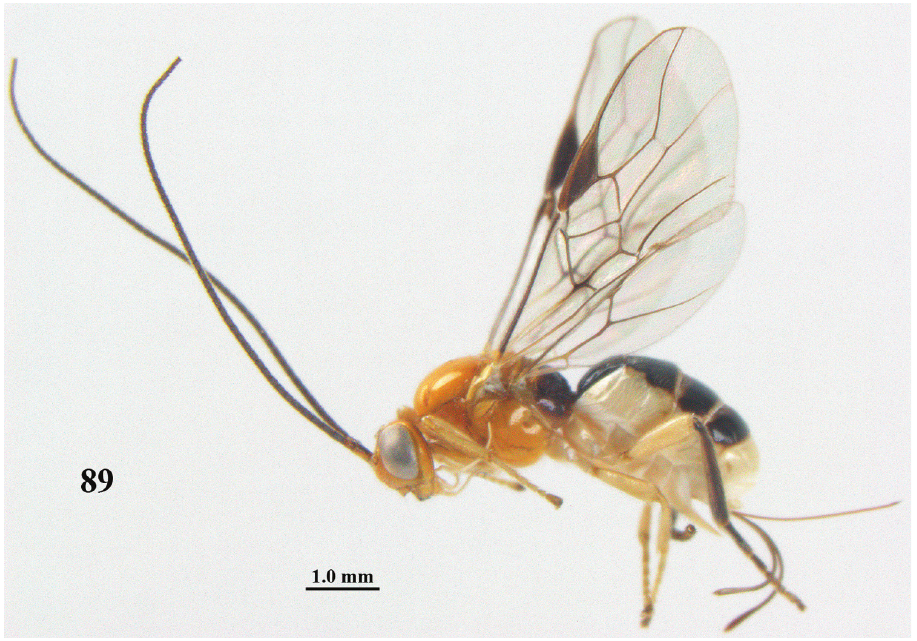
Figure 89. Psyttalia spectabilis sp. n., ♀ , holotype, habitus lateral. 97–98); length of maxillary palp 1.2 times height of head; length of eye in dorsal view 4.6 times temple (Fig. 96); temple in dorsal view shiny, largely smooth and with sparse punctures; OOL: diameter of ocellus: POL = 9:5:4; area behind stemmaticum with groove, widened laterally (Fig. 96); face moderately punctate with interspaces wider than diameter of punctures, except submedially, shiny and medio-longitudinal convexity mainly smooth and ventrally widened (Fig. 95); frons moderately depressed behind antennal sockets, shiny, rugose and glabrous but laterally setose and punctu- late, in front of anterior ocellus with narrow groove and narrow smooth ridge (Fig. 96); labrum flat; clypeus transverse, convex, coarsely punctate and its ventral margin slightly convex and thin (Fig. 95); width of clypeus 4.0 times its maximum height and 0.8 times width of face; hypoclypeal depression wide and deep (Figs 91, 95); malar space narrow (Fig. 95); malar suture indistinct except for deep depression near eye, between malar suture and clypeus punctate; mandible not twisted, apically moderately narrowed, punctate and with both teeth wide; mandible normal basally and with nar- row ventral carina (Fig. 91); occipital carina remains far removed from hypostomal carina and dorsally largely absent; hypostomal carina rather wide ventrally. Mesosoma . Length of mesosoma 1.3 times its height; dorsal pronope small, round; pronotal side largely smooth, but anterior and posterior grooves present and coarsely crenulate (Fig. 91); propleuron flattened; epicnemial area smooth dorsally; precoxal sul- cus medially medium-sized and only medially distinctly crenulate, absent anteriorly and posteriorly (Fig. 91); remainder of mesopleuron smooth and shiny; pleural sulcus